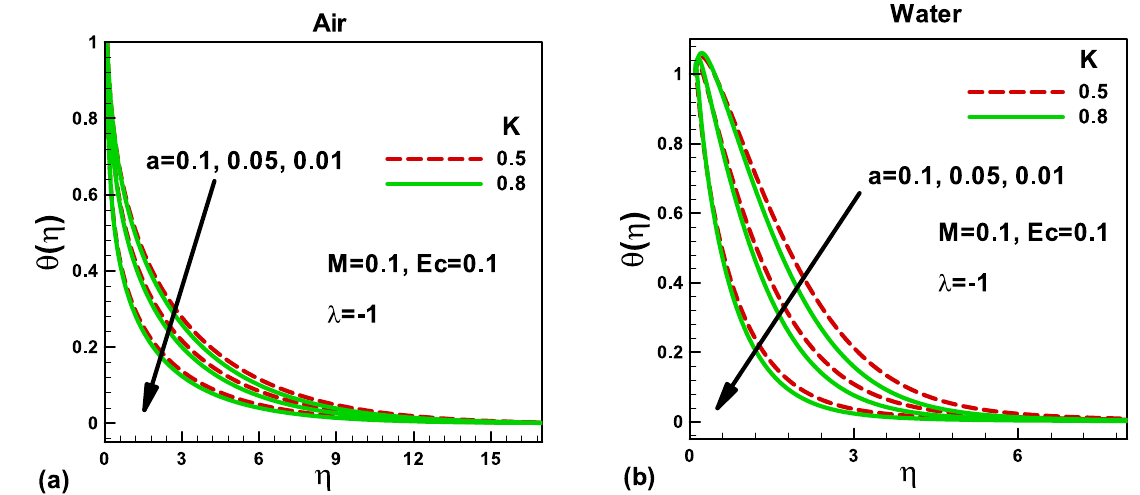
Figure 5. Effects of porosity parameter on dimensionless temperature for (a) air and (b) water, when the free stream is moving in the positive x-axis and the needle is moving in the opposite direction.